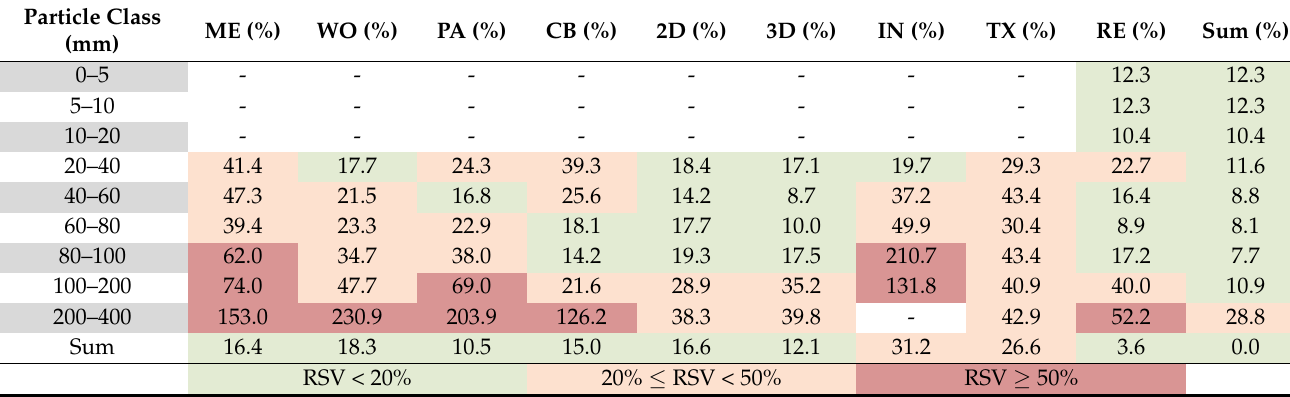
Table 4. Relative sampling variabilities (RSV) for various particle size classes and for the material classes metal (ME), wood (WO), paper (PA), cardboard (CB), 2D plastics (2D), 3D plastics (3D), inert materials including glass (IN), textiles (TX), and a residual fraction (RE)